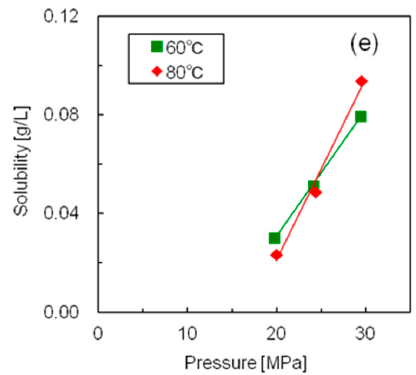
Figure 5. Solubilities of the five silicone resins at di ff erent temperatures and pressures in supercritical CO 2 ( a ) Resin S1; ( b ) Resin S2; ( c ) Resin S3; ( d ) Resin S4; ( e ) Resin S5.